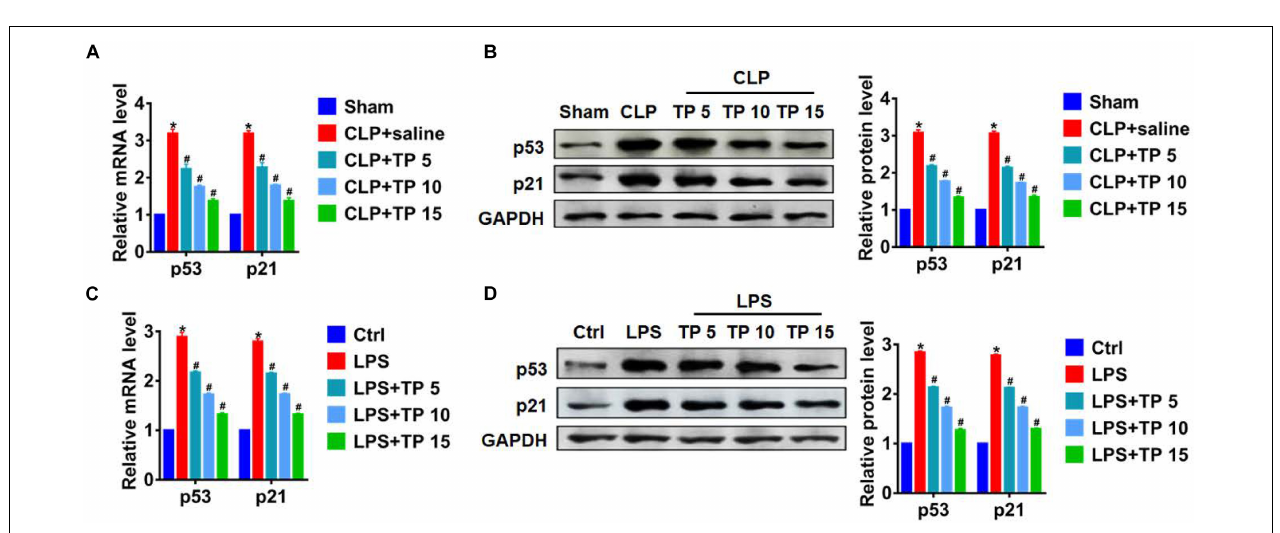
FIGURE 2 | TP attenuated apoptosis during lung injury. (A) Western blot for apoptosis related proteins (Bax, Caspase-3, Caspase-9) in lung tissues. n = 5, * P < 0.05 vs. Sham, # P < 0.05 vs. CLP. L2 cells treated with LPS (100 ng/mL) at different concentration of TP: 0, 5, 10, 15 µ g/ml. (B) MTT was used to detect cell viability. n = 10, * P < 0.05 vs. control, # P < 0.05 vs. LPS. (C) Apoptosis cell numbers were tested by TUNLE staining. n = 5, * P < 0.05 vs. control, # P < 0.05 vs. LPS. (D) Western blot for apoptosis related proteins (Bax, Caspase-3, Caspase-9) in L2 cells. n = 5, * P < 0.05 vs. control, # P < 0.05 vs. LPS.